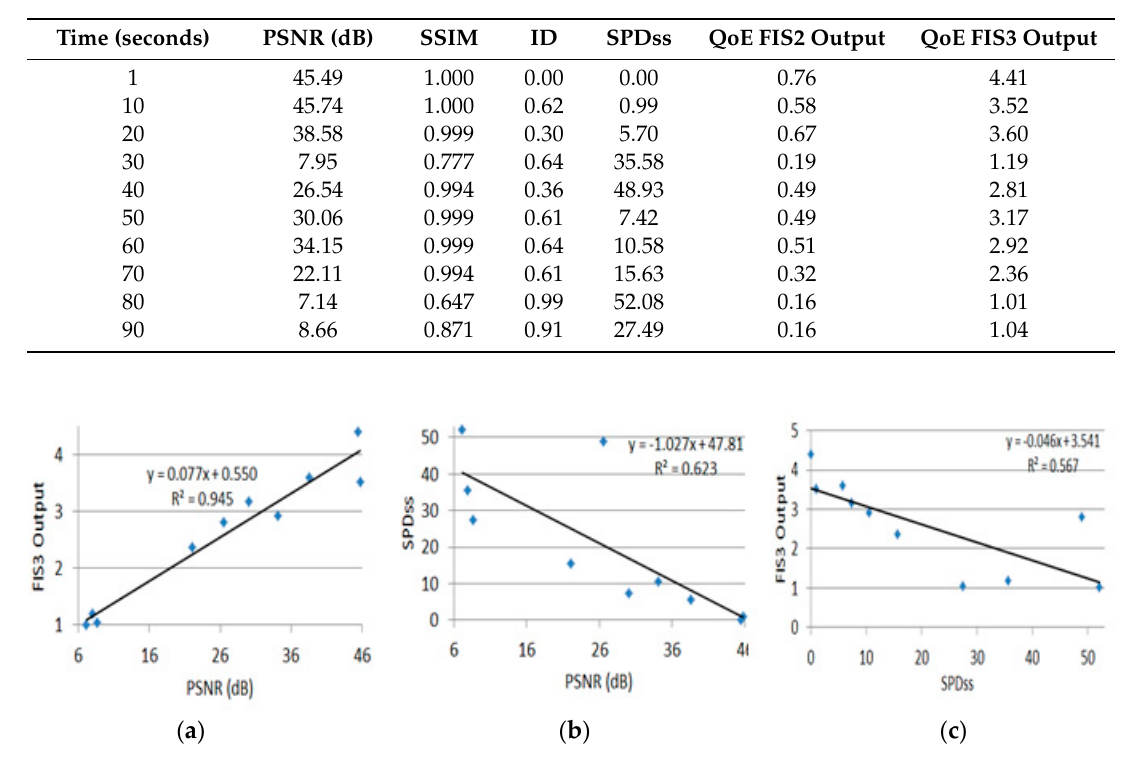
Figure 19. Plots for ( a ) FIS3 output against PSNR, ( b ) SPDss against PSNR and ( c ) FIS3 output against SPDss.